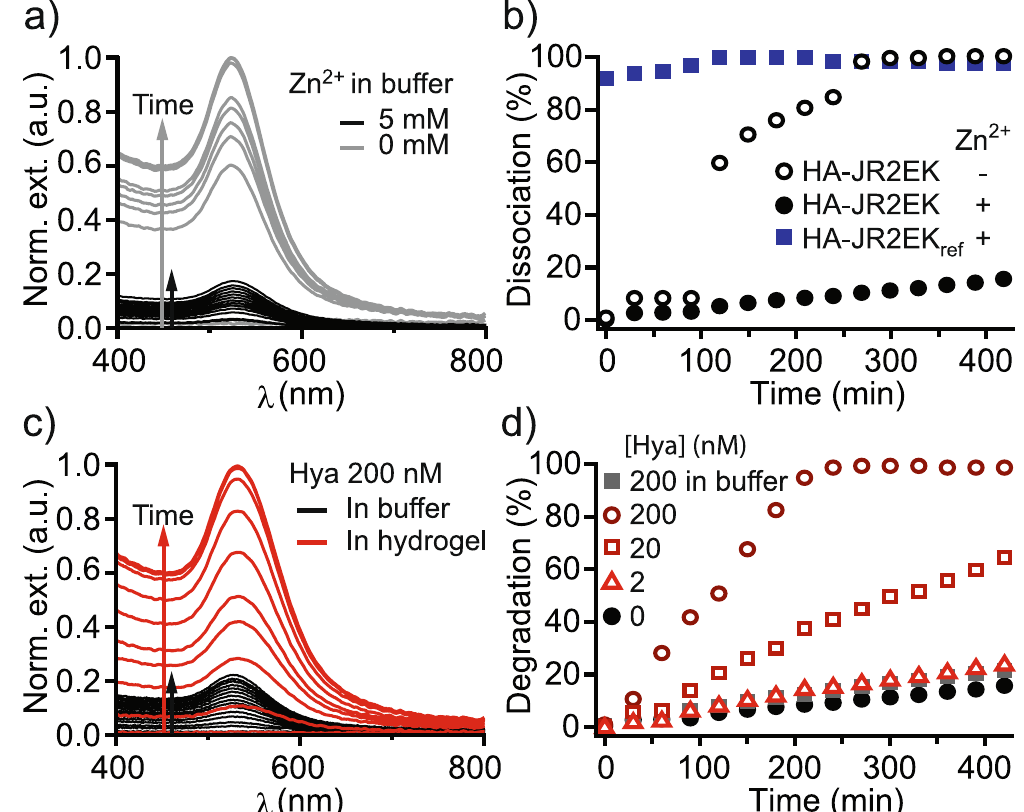
Figure 4. Dissociation and enzymatic degradation of hydrogels over time visualized by release of incorporated AuNPs. ( a ) UV-vis spectra of HA-JR2EK with JR2EC-AuNPs encapsulated within the hydrogel to visualize dissociation over time (measured every 30 min for 7 hours), in a buffer with and without 5 mM Zn 2 + . ( b ) Dissociation over time of hydrogels consisting of HA-JR2EK with and without 5 mM Zn 2 + in the buffer and HA-JR2EK ref with Zn 2 + in the buffer. ( c ) UV-vis spectra of HA-JR2EK with 200 nM hyaluronidase (Hya) in the buffer or encapsulated within the hydrogel in a Zn 2 + containing buffer. ( d ) Enzymatically catalyzed degradation over time of HA-JR2EK hydrogels with 0–200 nM hyaluronidase encapsulated within the hydrogel or 200 nM outside the hydrogel. HA-JR2EK and HA-JR2EK ref concentrations were 2.5 wt % in all experiments and hydrogels were assembled using 10 mM Zn 2 +